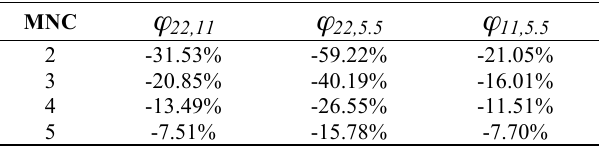
Table 12. Change in Average CPD in Cluster Fields When Decreasing Communications